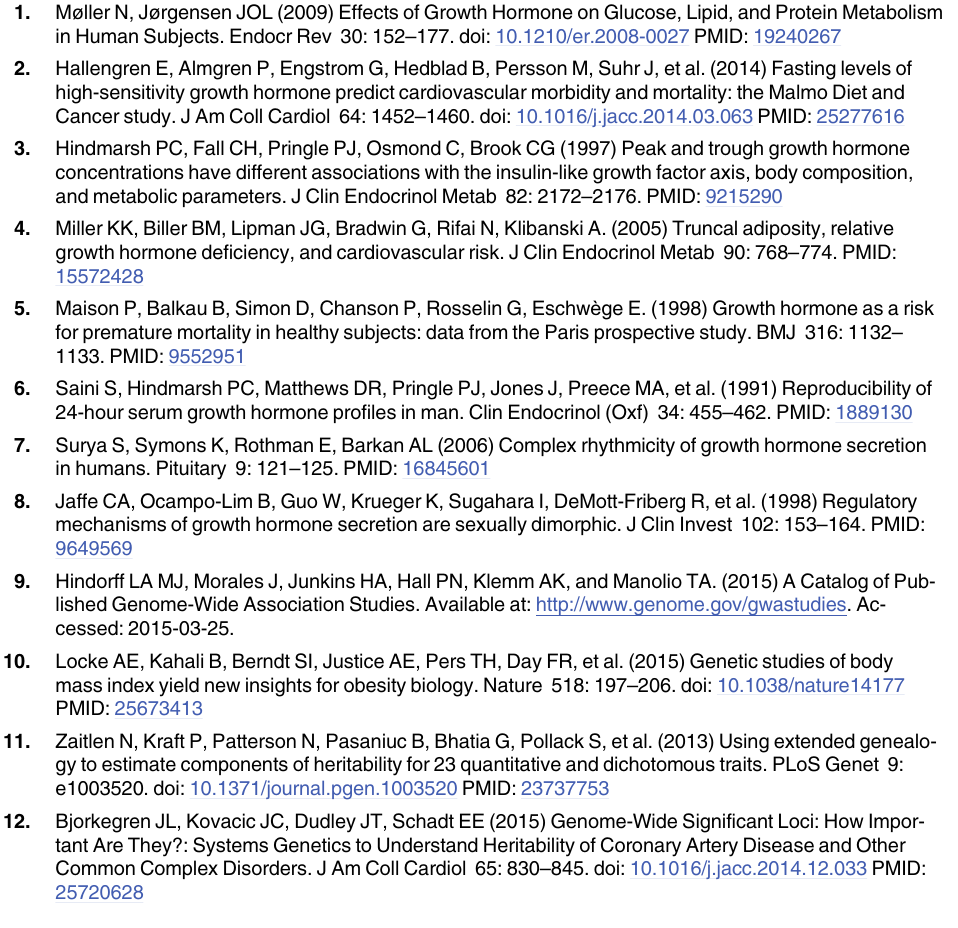
S1 Fig. Illumina cluster plot for rs35699176. Cluster plot showing genotyping for snp in ZNF77 . NB, samples with black dots did not pass our quality criteria for genotyping and were thus excluded from the study. (TIFF) S2 Fig. Illumina cluster plot for rs121909305. Cluster plot showing genotyping for snp in MYO1A .